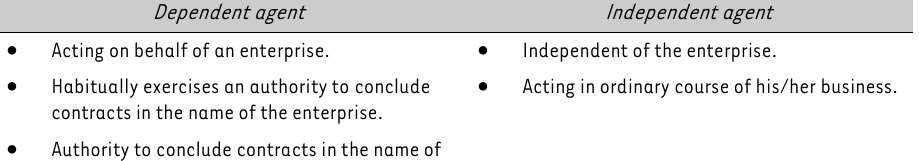
TABLE 5: Comparison of the requirements relating to a dependent agent with those of an independent agent Dependent agent Independent